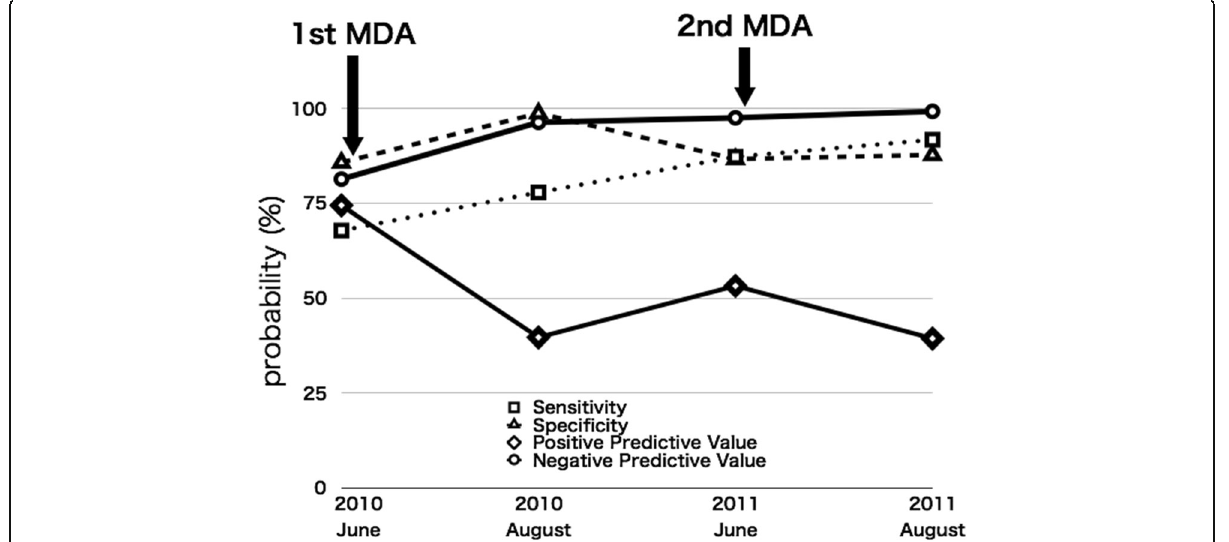
Fig. 3 Analysis for the results of occult blood by urine strip tests